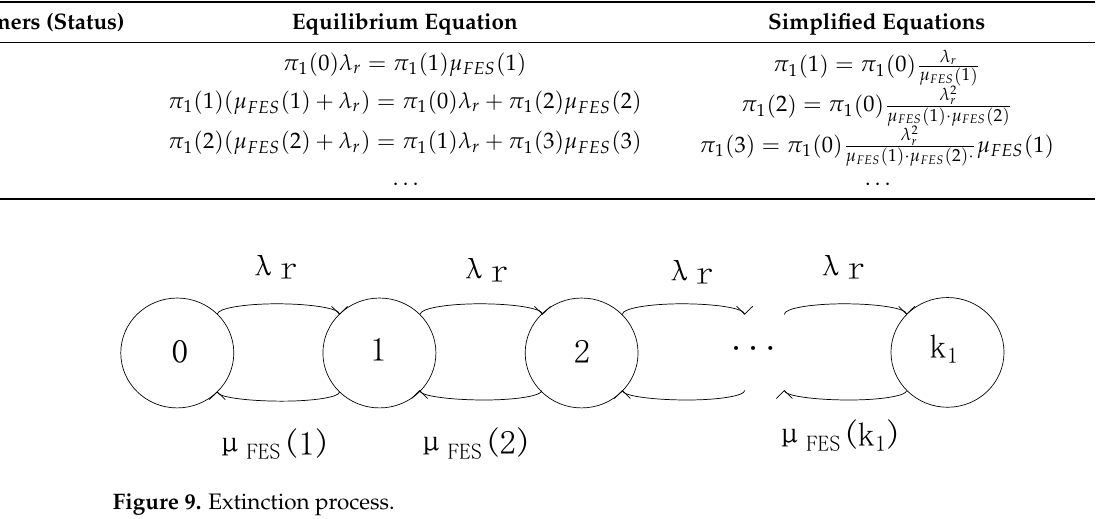
Table 3. Equilibrium equation transfer table.